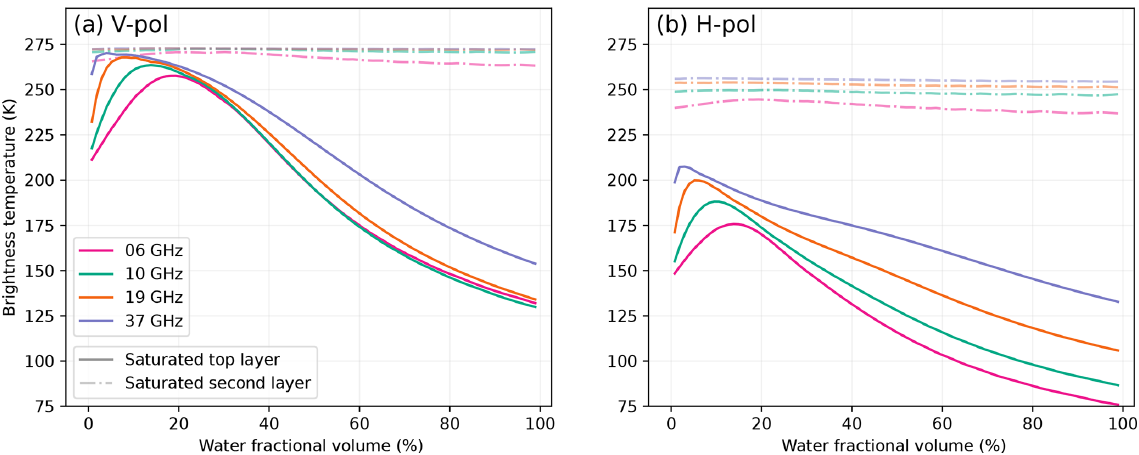
Figure 15. Brightness temperature of a water-saturated layer as a function of the water proportion (the remaining proportion is ice). The saturated layer is located at the top of the snowpack (solid lines) and 5cm below a wet snow layer (5kgm − 2 , dashed lines).